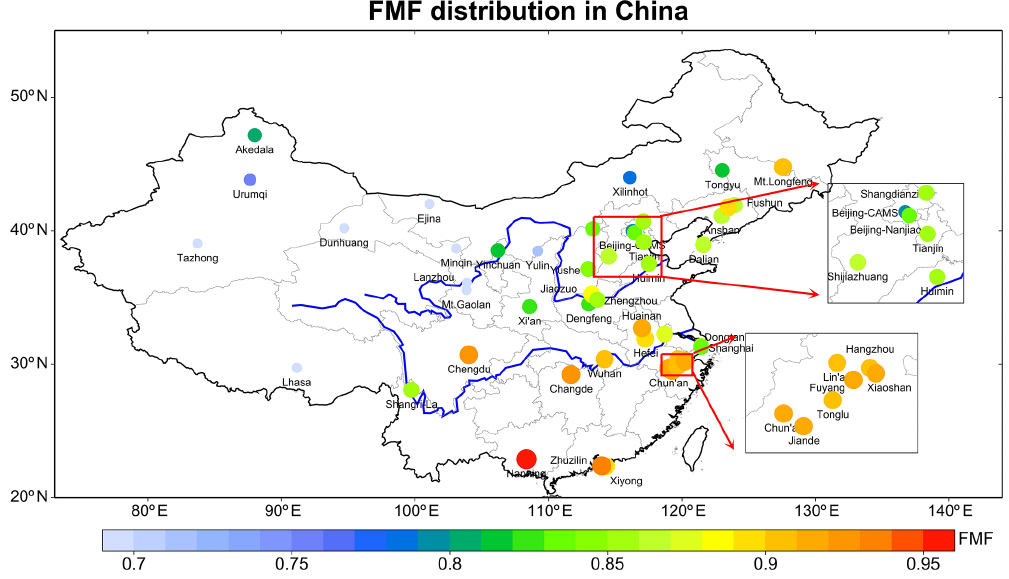
Figure 4. Annual spatial distribution of fine-mode fraction at the CARSNET